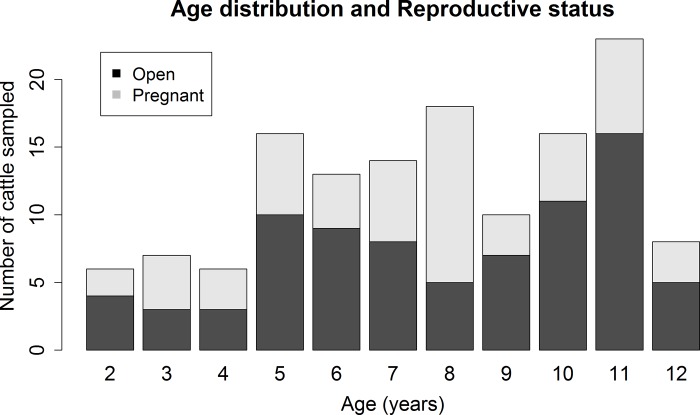
Age distribution and reproductive status of the 137 sampled female cattle.A total of 59% of cattle were open and 41% pregnant.